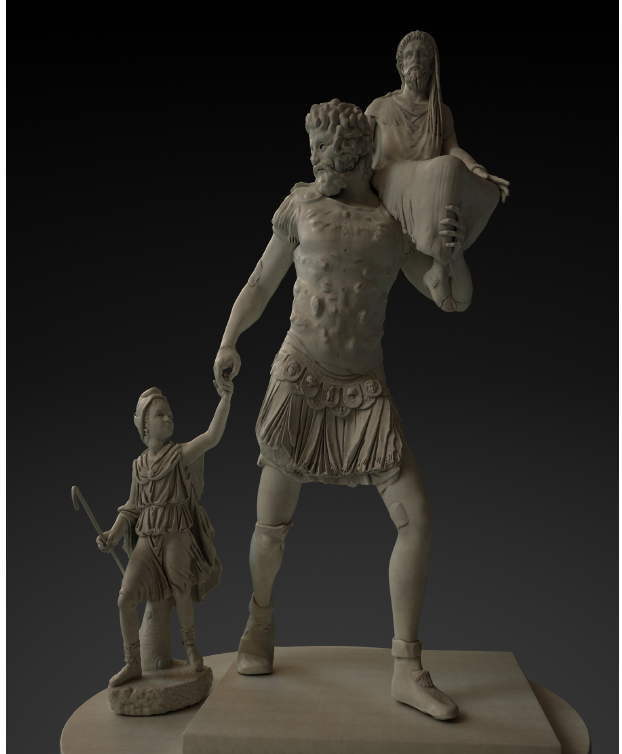
Figure 16. Rendered representation of our proposal for the Roman masterpiece called Aeneas